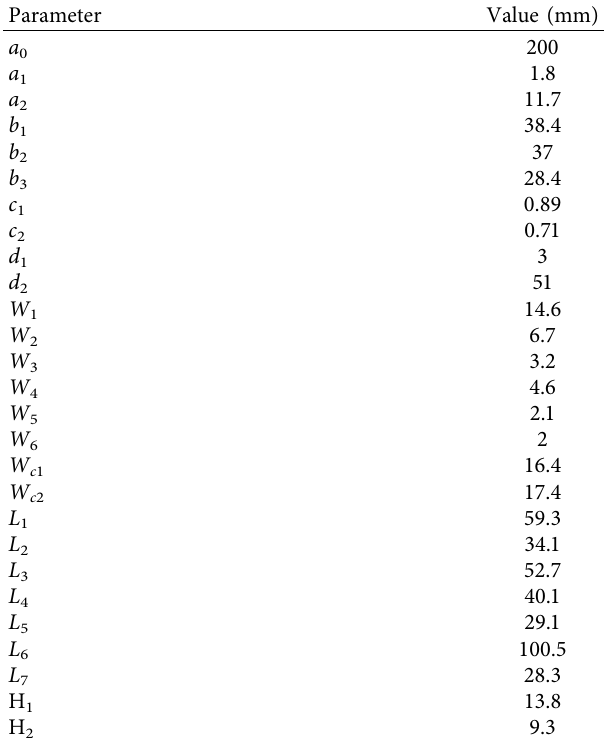
Table 1: Structure